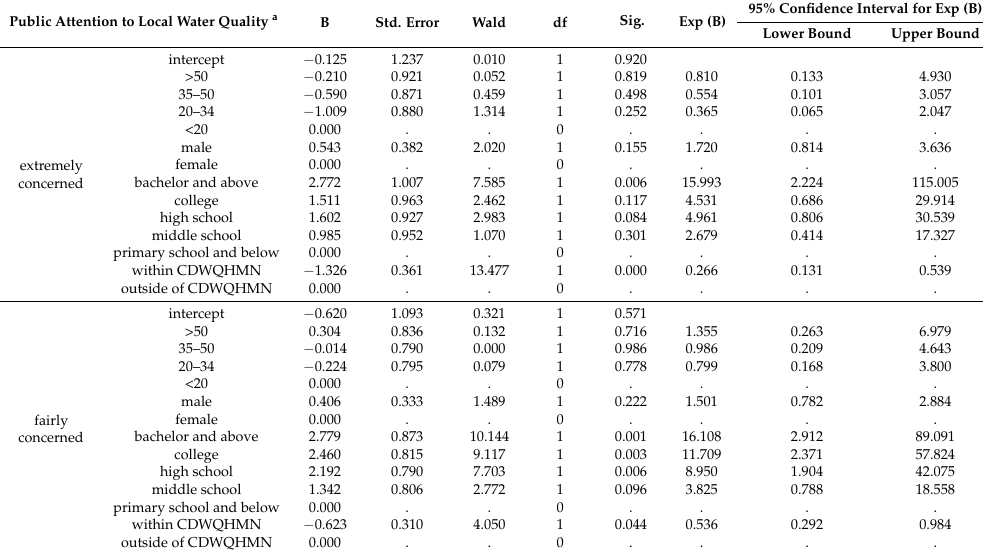
Table 5. Results of multinomial logistic regression analysis for public attention to local water quality and its influencing